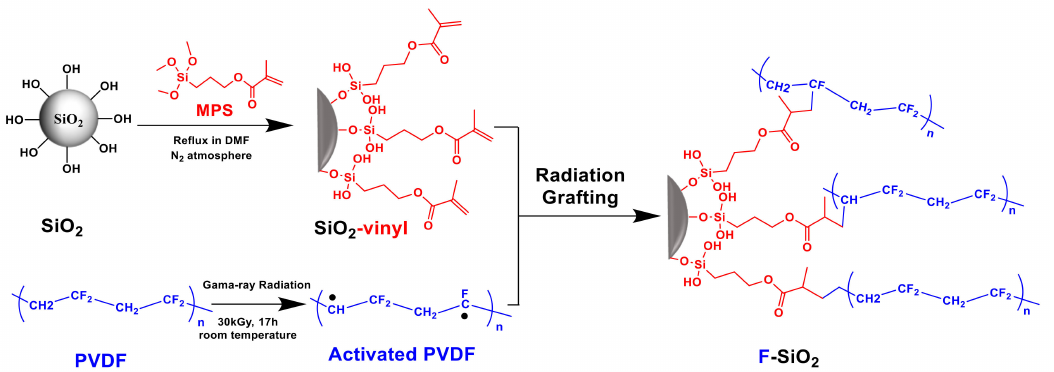
Figure 2. Illustrative synthesis of F-SiO 2 through a “radiation-induced graft polymerization”